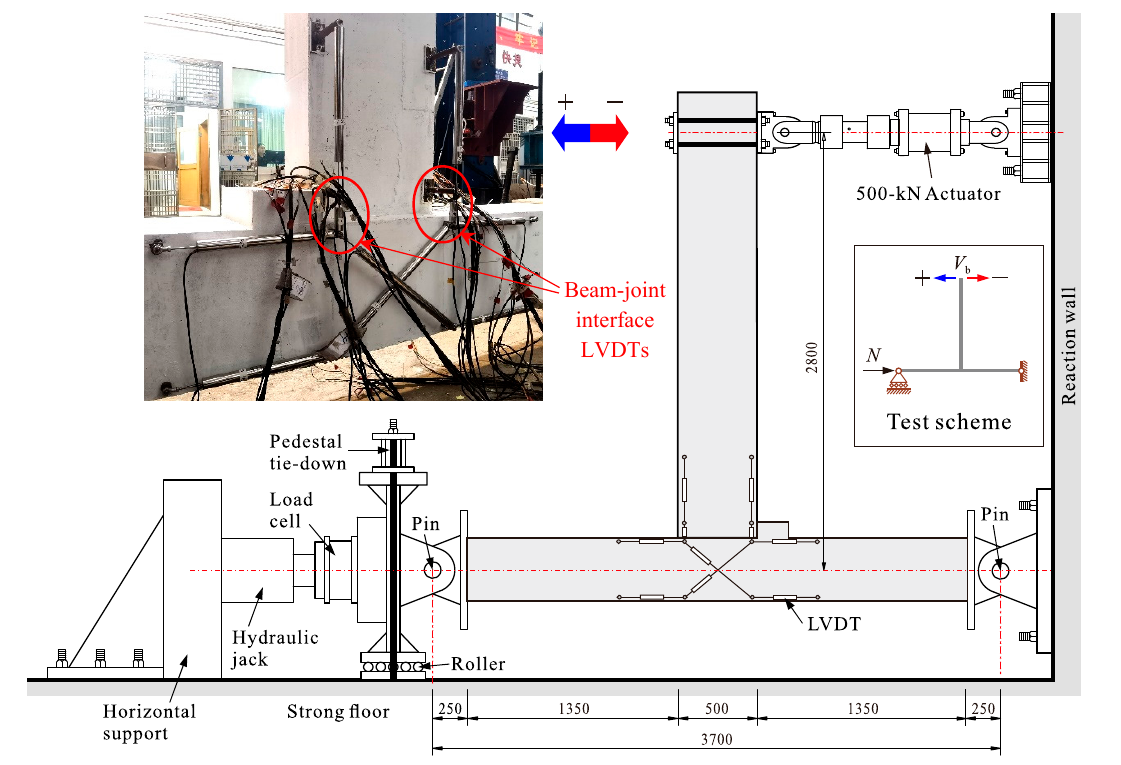
Figure 4. Test setup and instrumentation (unit: mm).